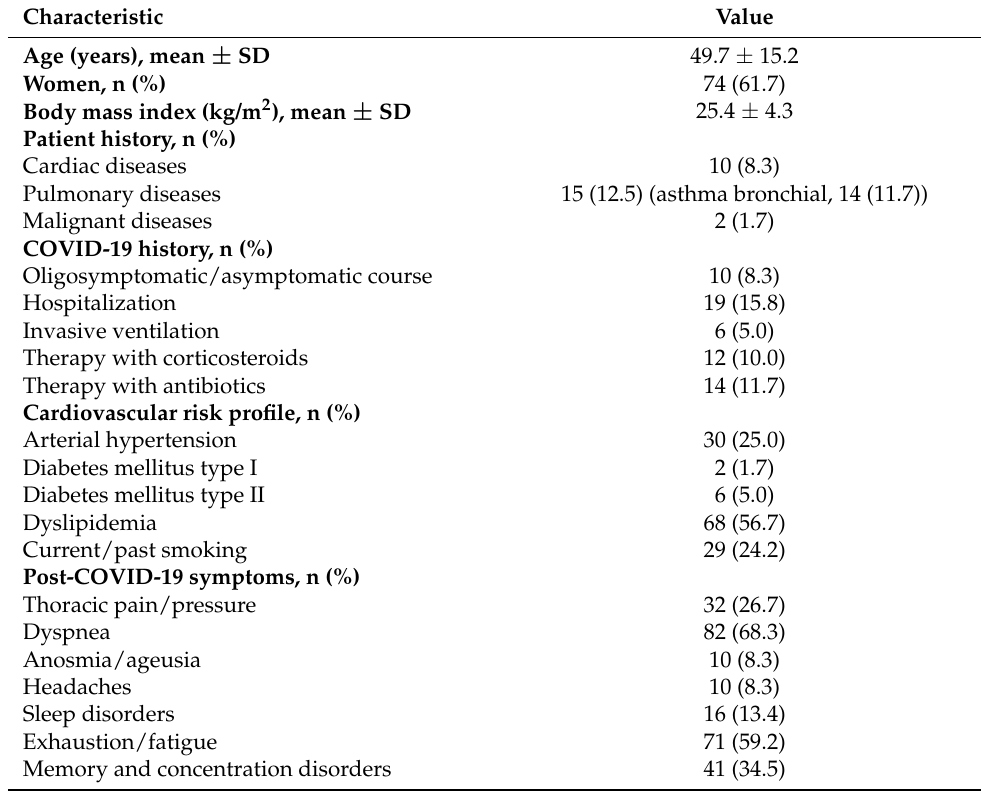
Table 1. Patient characteristics (n = 120).